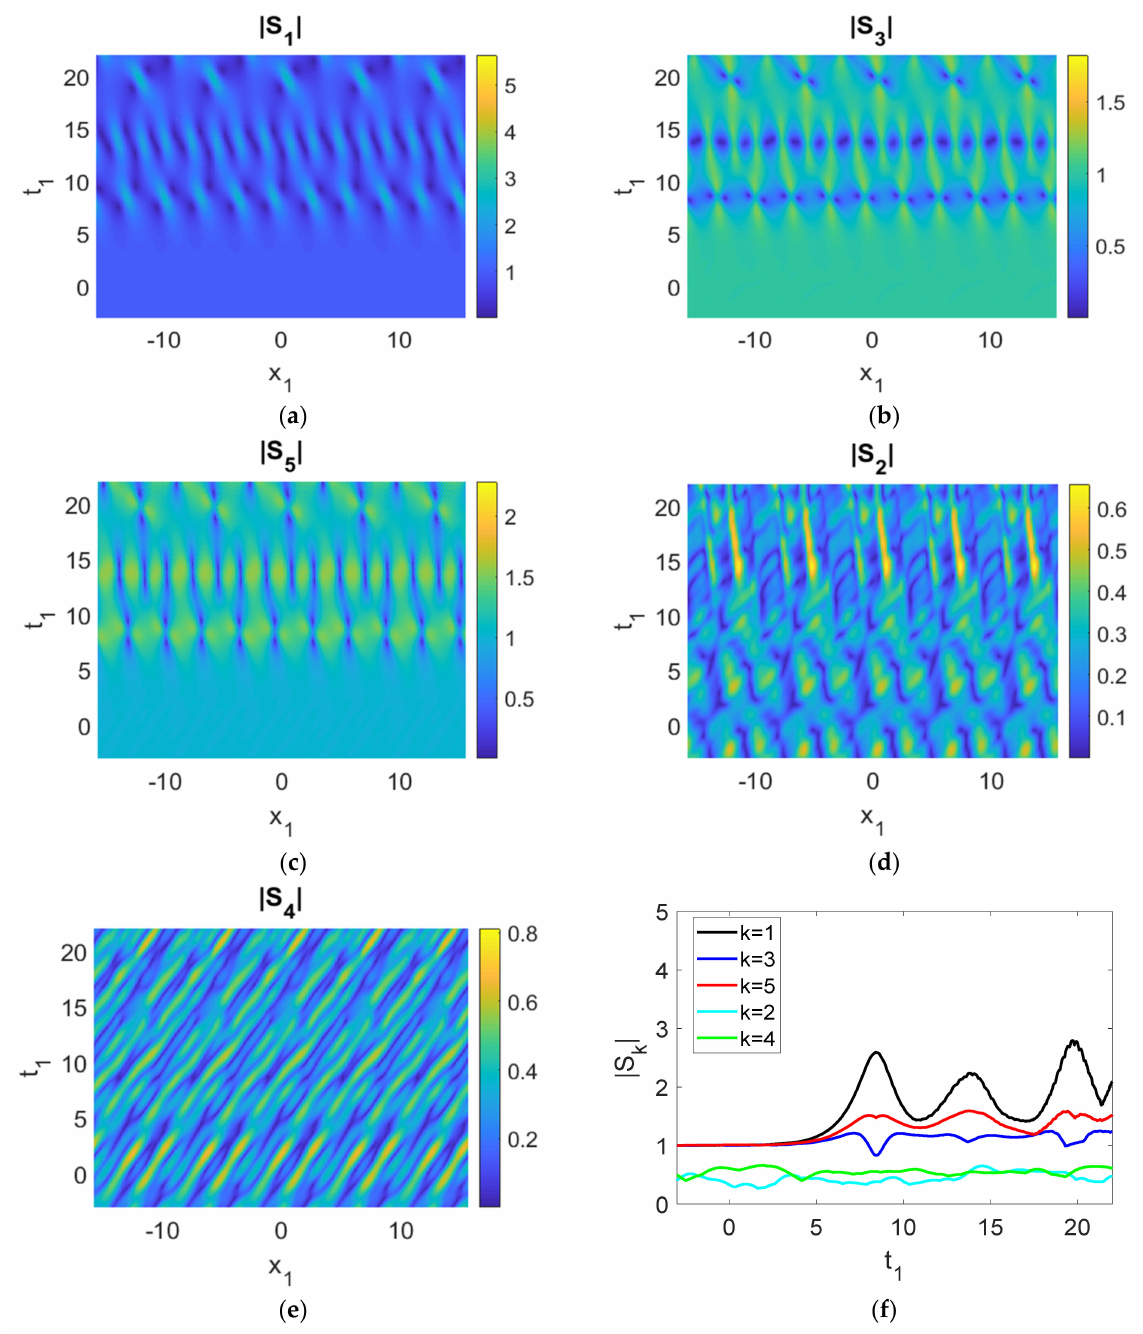
Figure 10. ( a – e ) Evolution of the five wave components; ( f ) time history of the moduli of the envelopes, |S k |. Parameters used were c g 1 = − 0.5, c g 3 = 1, c g 5 = 0.5, c g 2 = − 0.1, c g 4 = 0.6, γ 1 = 1, γ 3 = − 1, γ 5 a = 1, γ 2 = − 0.5, γ 4 = 0.5, γ 5 b = − 0.05, a 2 = 1, ρ ρ ρ ρ ρ δ = 1 = 3 = 5 = 1, 2 = 4 = 0.1,